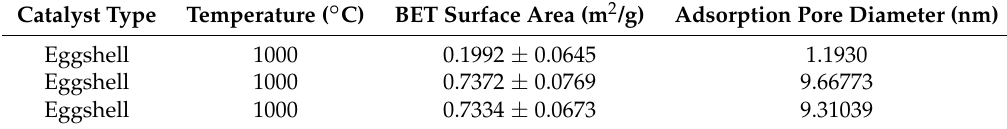
Table 2. Brunauer–Emmett–Teller (BET) surface area measurements and porosity characterization. Catalyst